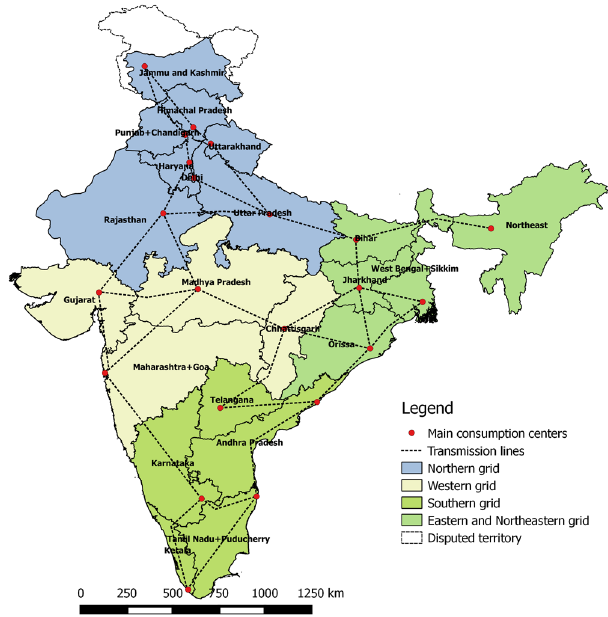
Fig. 9 | The four major regions constituted by the corresponding states/ regions. Indiahas fi veregionalgrids.Inthisanalysis,wehavecombinedtheEastern and Northeastern grids to form an Eastern grid, so we have four regional grids. All themajorstatesareconsideredasshown,whilesmallerstatesandunionterritories arecombinedtotheneareststate,exceptDelhi.Theindividualstateswithineachof the regional grids are interconnected, and the regional grids are interconnected with each other.These transmission lines enable imports and exports between the states. It is assumed that the existing network of alternating current (AC) lines within the individual states will provide electricity to all end